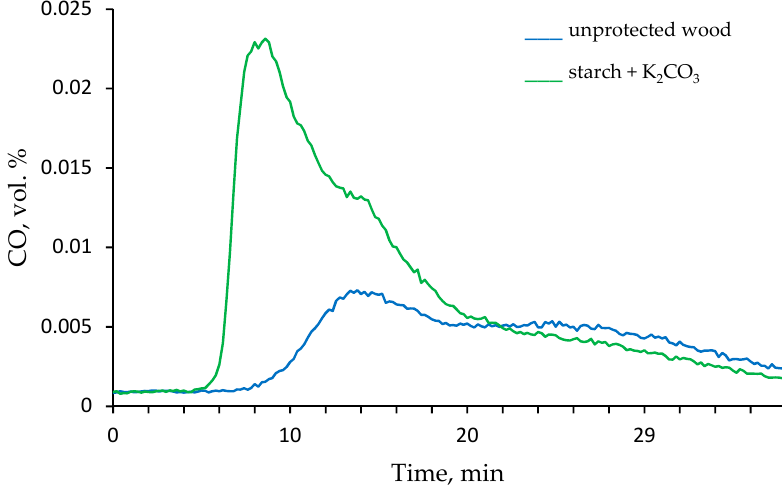
Figure 5. The time dependence of the amount of CO produced by unprotected wood and by the wood coated with ‘starch + K 2 CO 3 ’ formulation in the tube furnace (350 °C, nitrogen atmosphere).